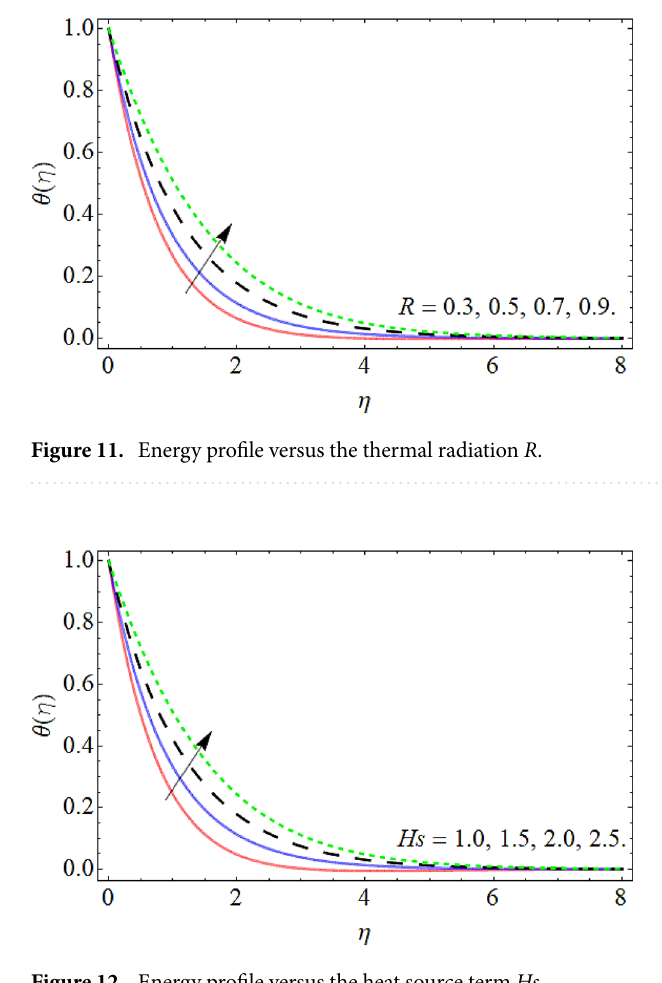
Figure 12. Energy profile versus the heat source term Hs .